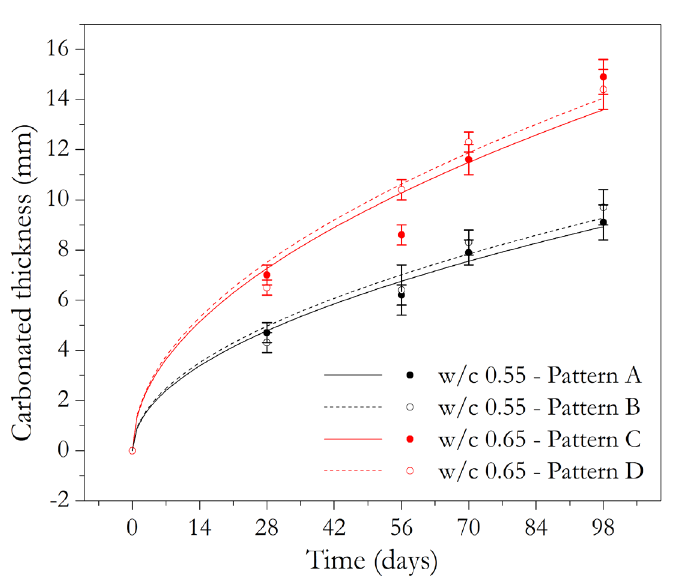
Figure 5. Advance of carbonation front in the samples submitted to the accelerated carbonation